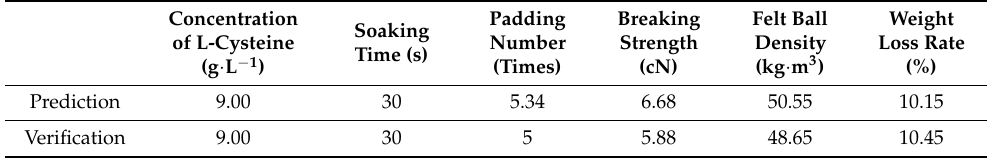
Table 5. Model predicted parameters for optimal finishing process and the results of the valida- tion